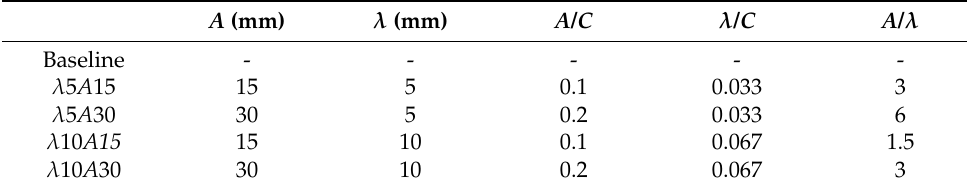
Figure 4. ( a ) Isometric drawing of the NACA 65(12)-10 aerofoil model with blowing leading edge; ( b ) streamwise devel- opment of the velocity profiles produced by the leading edge blowing under the configuration of λ ’ = 5 mm, Q = 208 L/min, and quiescent condition.